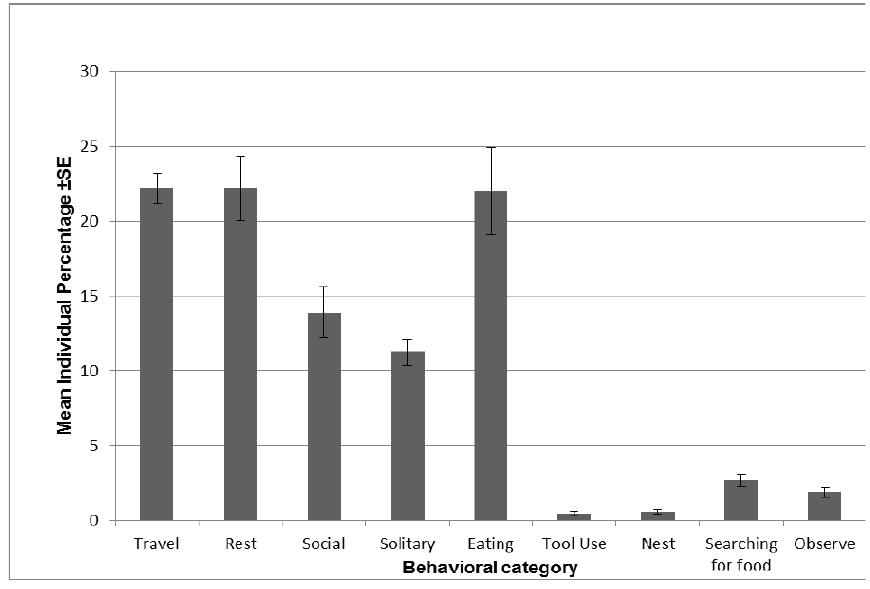
Figure 2. Mean individual percentage of time spent (±1 SE) across the nine main behavioral categories recorded during continuous focal follows.